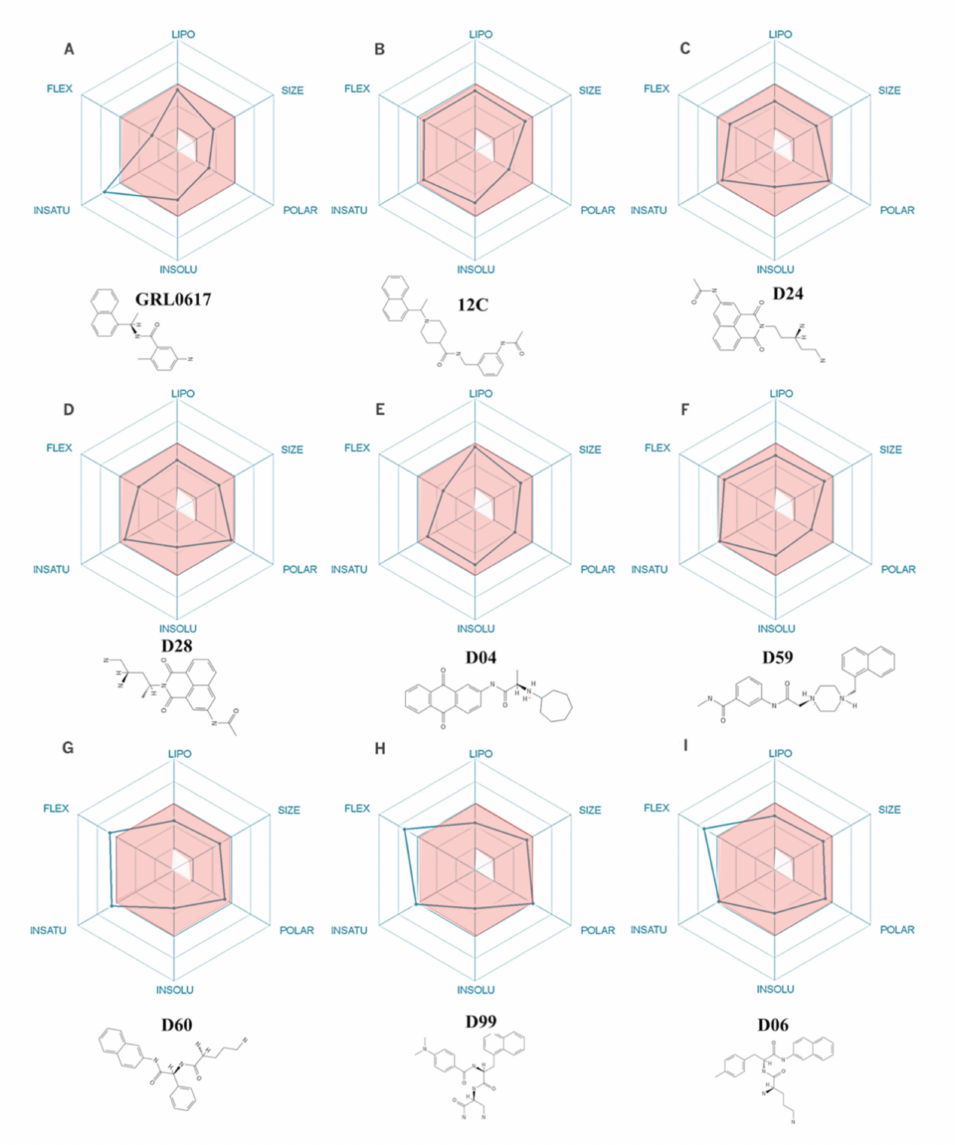
Figure 2. ( A – I ) Bioavailability radar of the selected compounds. The red area represents the op- timal range for each property (lipophilicity: XLOGP3 between − 0.7 and +5.0, size: MW between 150 and 500 g/mol, polarity: TPSA between 20 and 130 Å 2 , solubility: log S not greater than 6, saturation: fraction of carbons in sp3 hybridization, not less than 0.25, and flexibility: no more than 9 rotatable bonds). Under each bioavailability radar, the 2D chemical structure of each